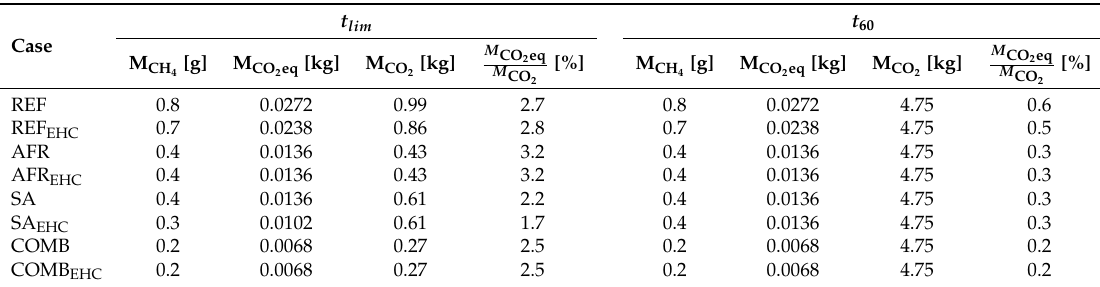
Figure 11. Mean emission concentrations with respect to reference case and legislation limits for the entire cold-start procedure. Table 4. Comparison of equivalent CO 2 emissions to unavoidable CO 2 emissions due to combustion for two separate time periods (GWP =